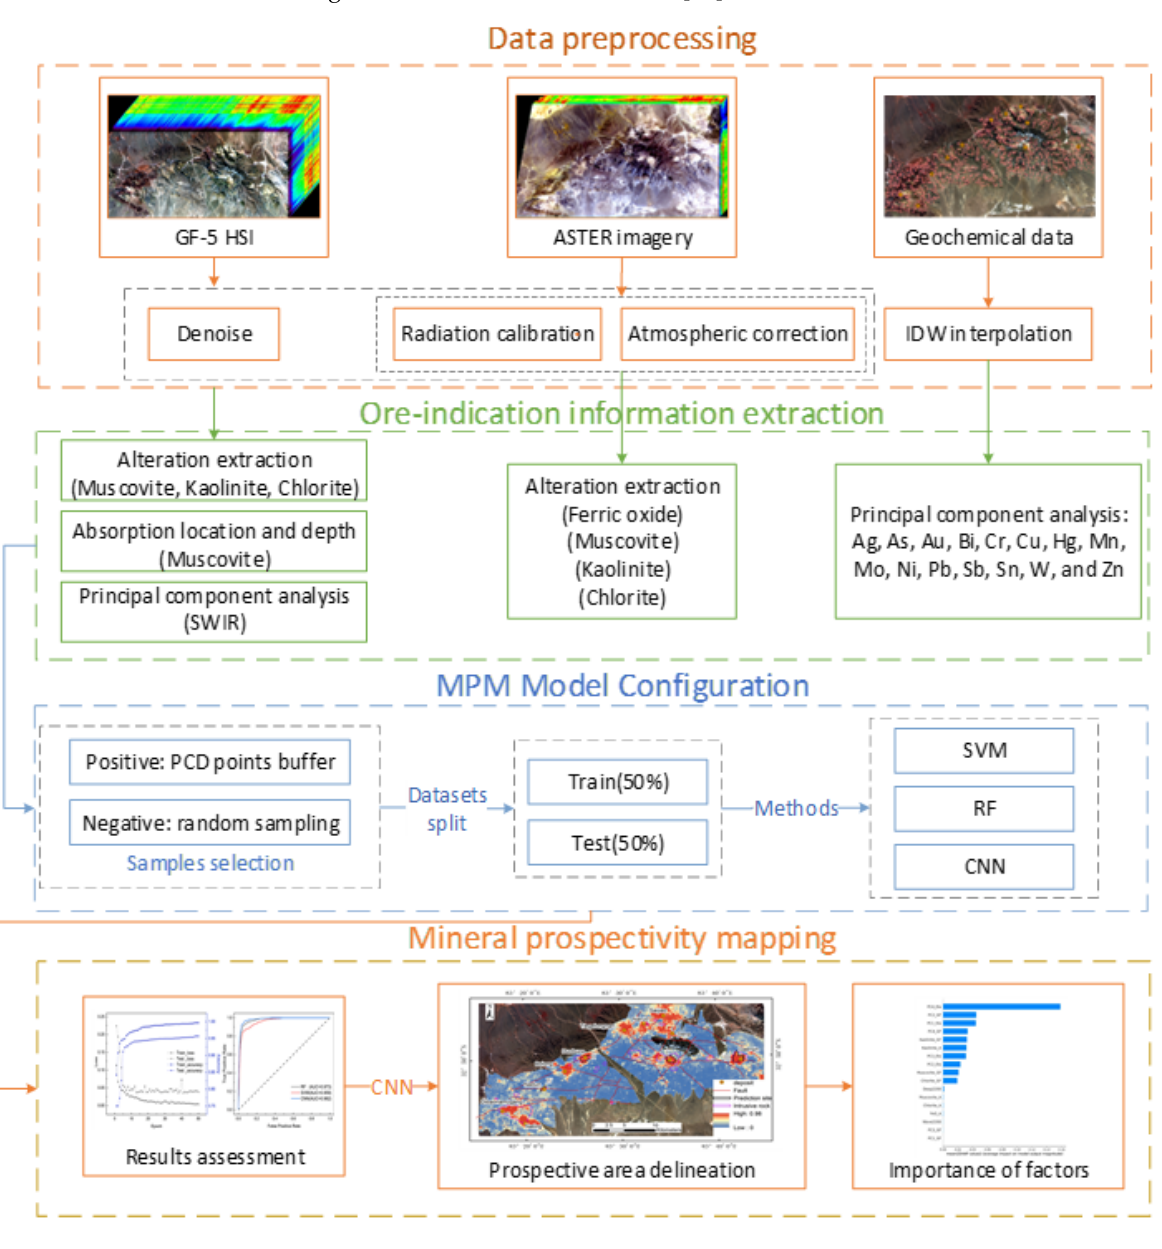
Figure 2. Experimental flow chart.